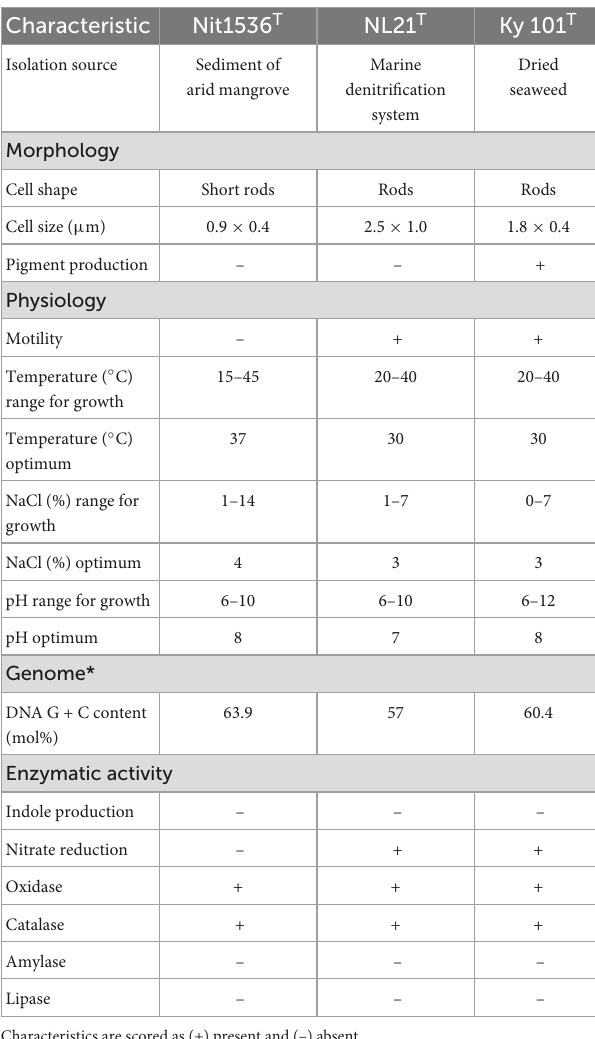
TABLE 3 Differential phenotypic characteristics of strain Nit1536 T and closely related species of Nitratireductor genus, namely, N. aquibiodomus NL21 T (DSM 15645) (Labbé et al., 2004) and N. kimnyeongensis Ky 101 T (DSM 19185) (Kang et al.,